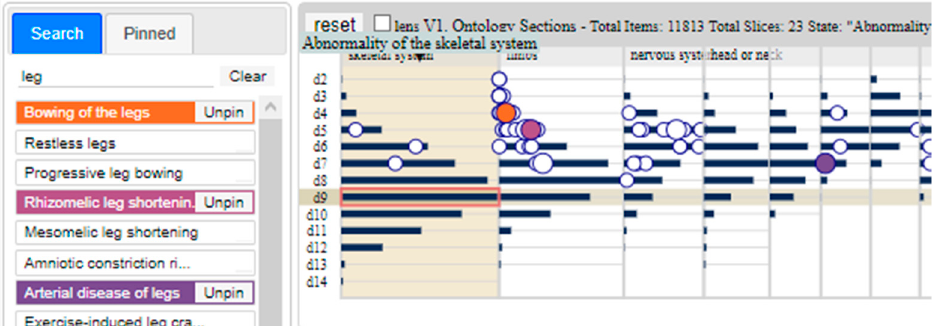
Figure 9. A depiction of Ontology Entity Search, showing a search activity which has resulted in three ‘Pin’ interactions. Ontology Entity Pinning